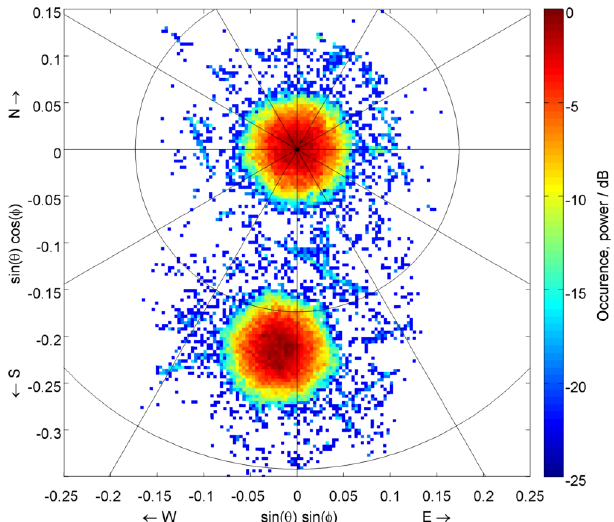
Figure 7. Angular occurrence of meteor head echo trajectory points observed on 15 December 2013 for two beam-pointing directions, φ = 0 ◦ , θ = 0 ◦ and φ = 185 ◦ , θ = 12 . 4 ◦